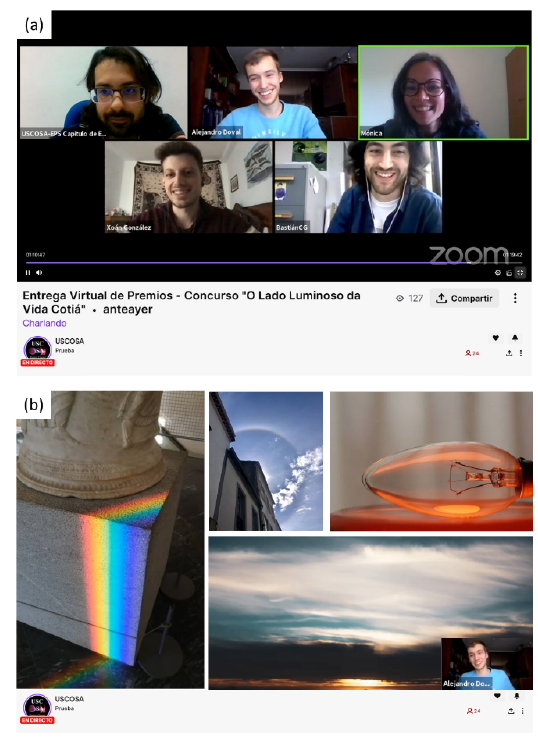
Figure 2. Awarding ceremony of The bright side of everyday life transmedia activity held in Twitch. a) Five members of the chapter participated in the ceremony where b) the analysis, dis- cussion and explanation of the optical phenomena behind each picture was performed in a relaxed